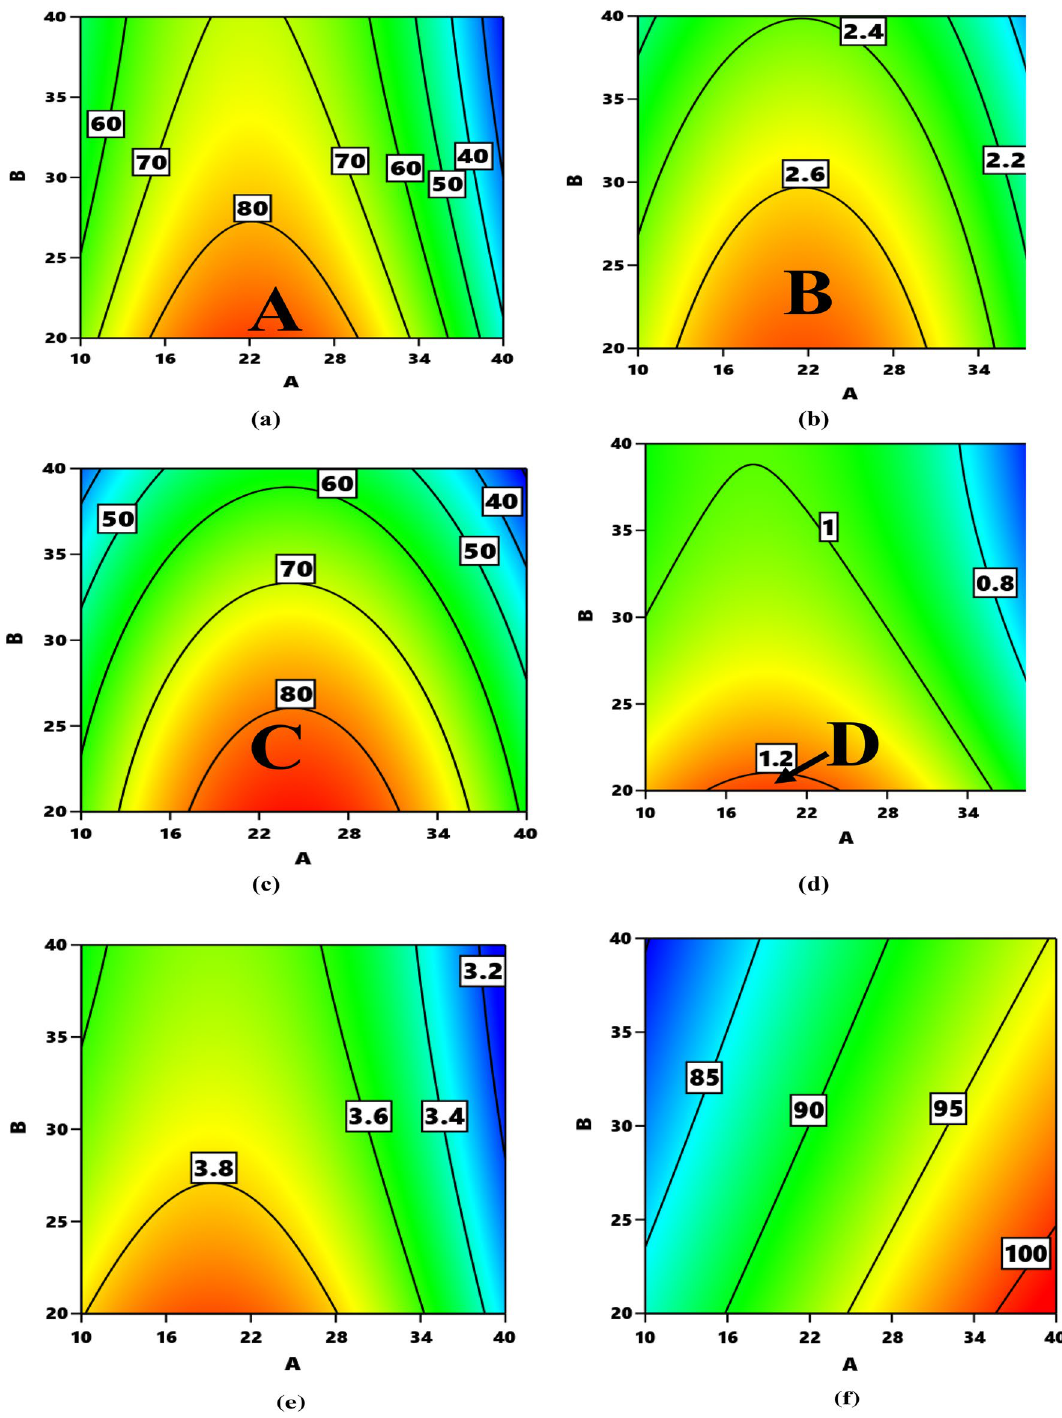
Figure 6. Contour plots for the relationship particulate proportion vs particulate size with respect to ( a ) tensile strength ( b ) tensile modulus ( c ) flexural strength ( d ) flexural modulus ( e ) impact strength ( f ) hardness. A is particulate proportion, B is particulate